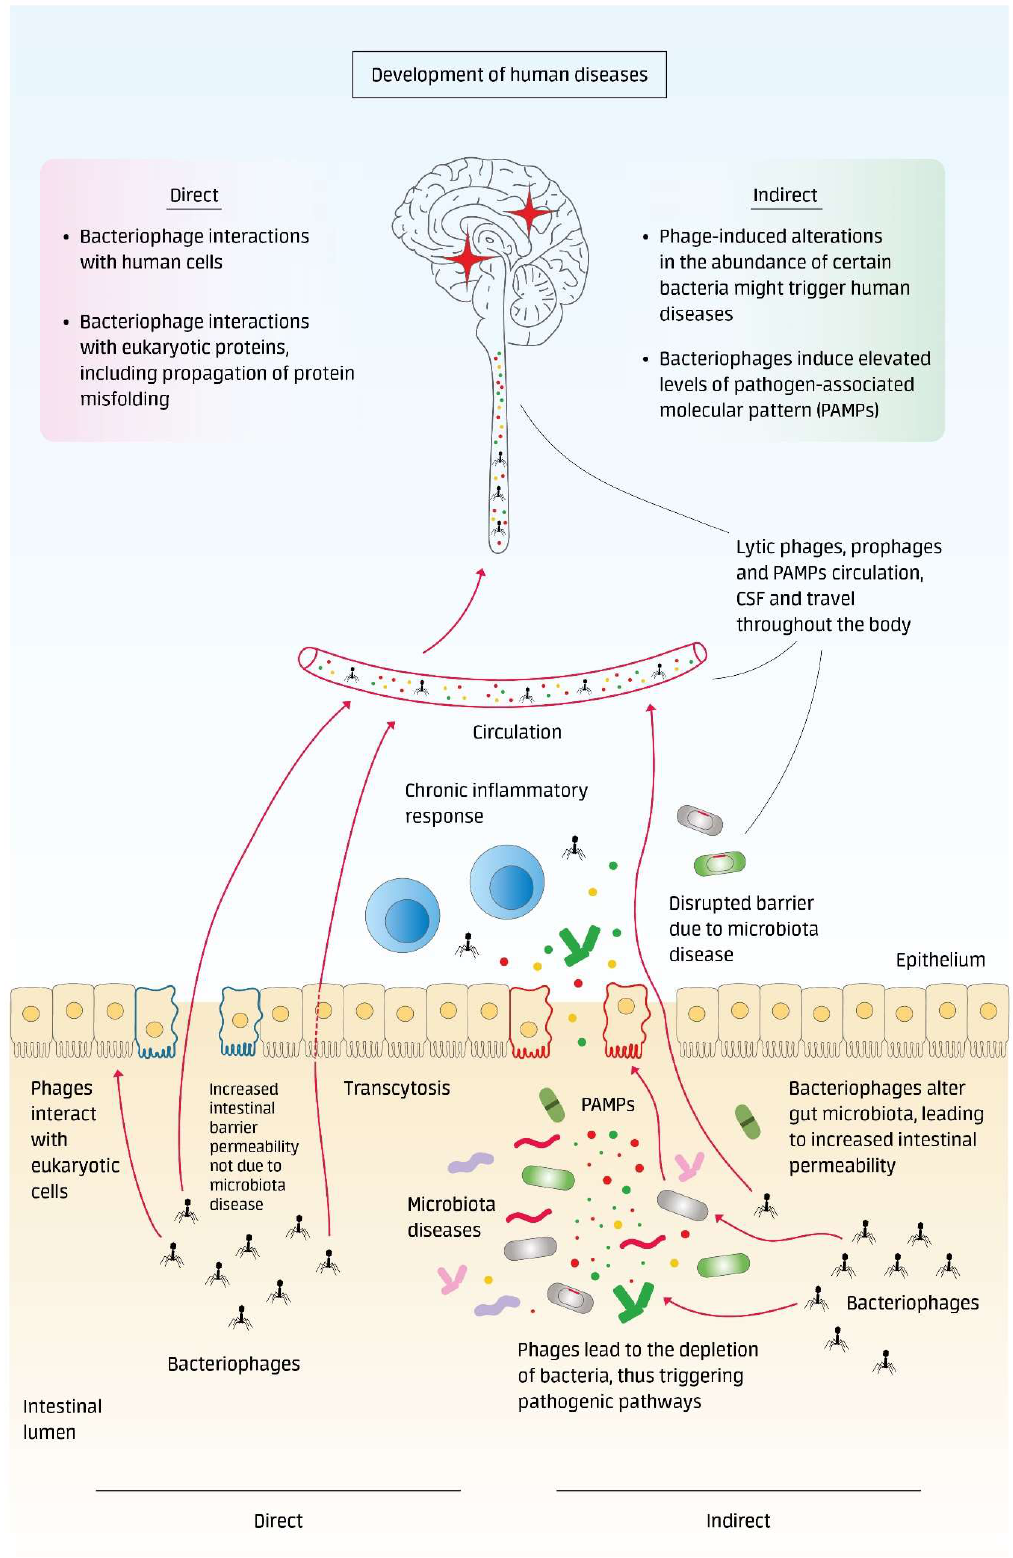
Figure 1. Bacteriophage concept of human diseases. Direct interaction of phages with the host macroorganism (eukaryotic cells and proteins). Indirect interaction with the host macroorganism by causing harmful microbiota alterations and microbiota-related diseases.